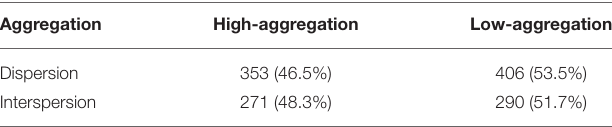
TABLE 7 | Frequencies of first fixation target as a function of aggregation type and aggregation